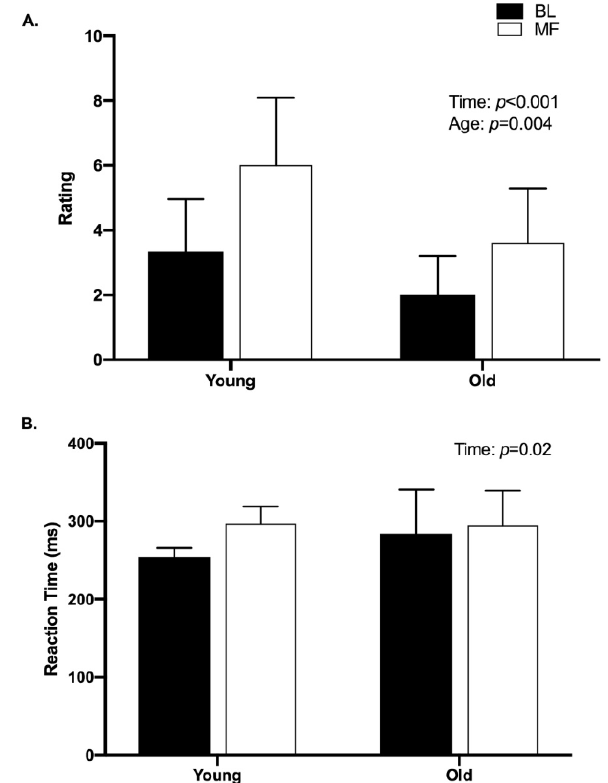
Figure 3. ( A ) Subjective fatigue ratings. Higher values indicate higher feelings of fatigue. After the mental fatigue task (MF), ratings were significantly higher ( p < 0.001) than ratings at baseline (BL). Older women reported lower fatigue than younger adults ( p = 0.004). ( B ) Psychomotor vigilance task = reaction time. MF times were significantly slower than BL ( p = 0.02). reaction time. MF times were significantly slower than BL ( p